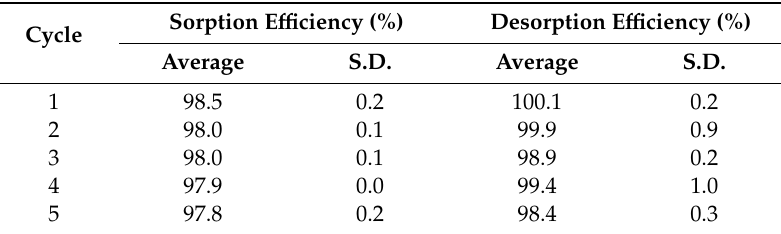
Table 5. U(VI) desorption and sorbent recycling for Q-APEI. Sorption E ffi ciency Cycle